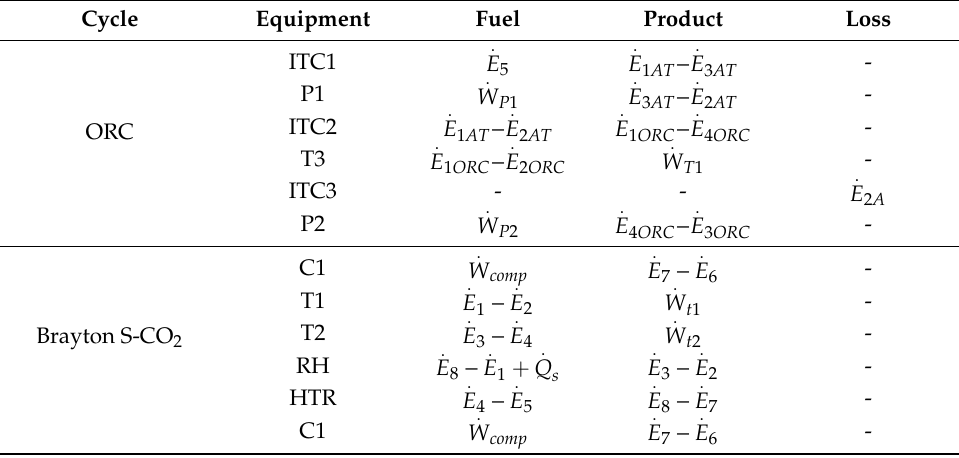
Table 1. Fuel-Product definition for the ORC and Brayton S-CO 2